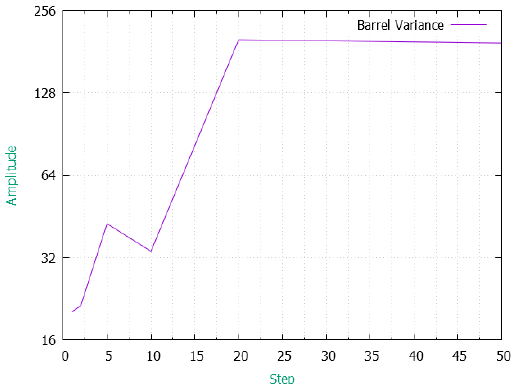
Figure 12. Plot barrel distortion mean 64x64 px